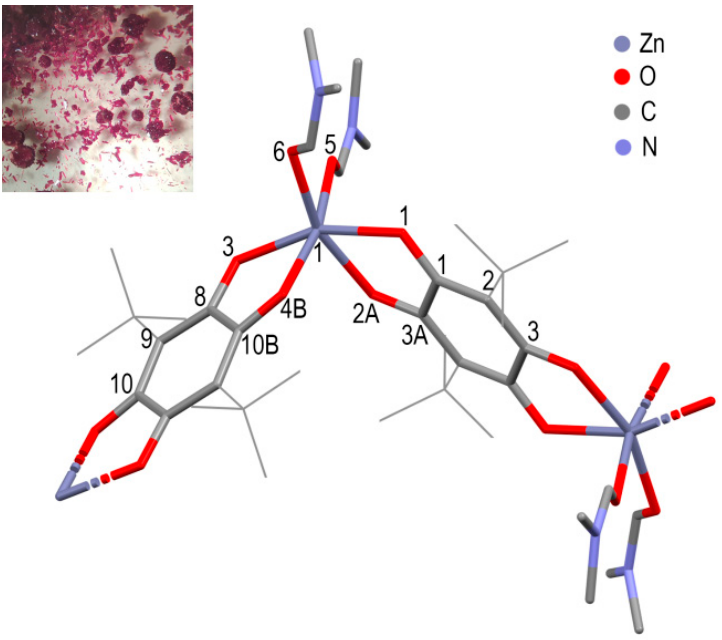
Figure 4. The view of molecular structure of the crystallographic unit in 2 . Photo of crystals is in the inset.